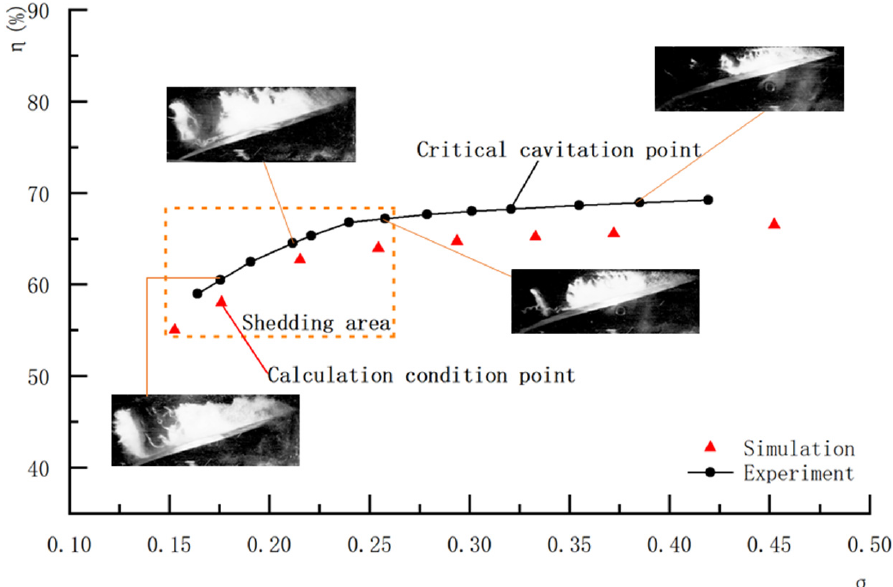
Figure 8. Comparison of η - σ between numerical simulation and experiment.